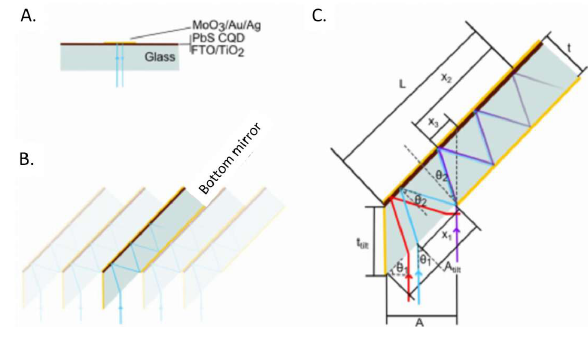
Fig. 7. Configuration and geometric considerations in FLP CQD solar cells. (A) Conventional double-pass CQD solar cell configuration. (B) Periodic arrangement of FLP CQD solar cells. (C) Geometric con- siderations for multipass absorption in the FLP cell. Reprinted with permission from [236]. Copyright 2013 Macmillan Publishers